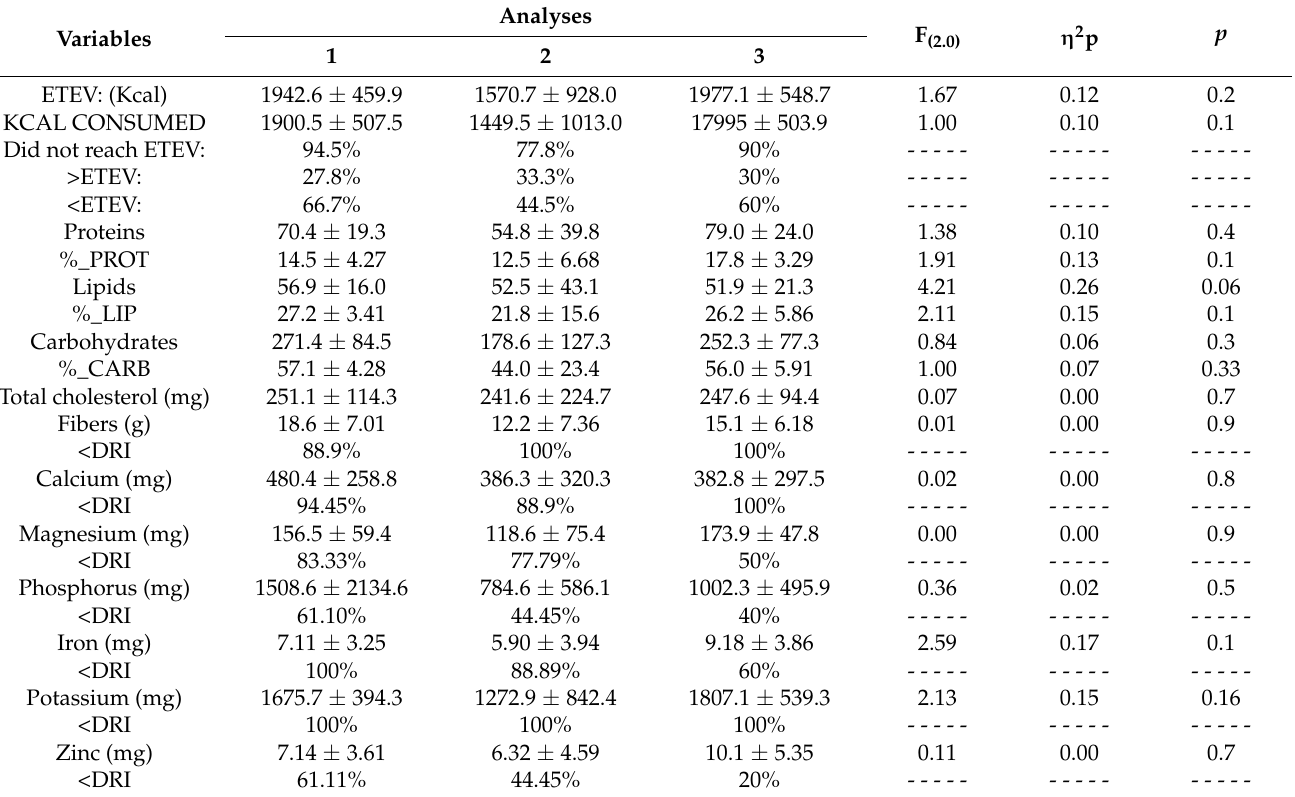
Table 4. Analysis of 24HR over time of children and adolescents with HIV.